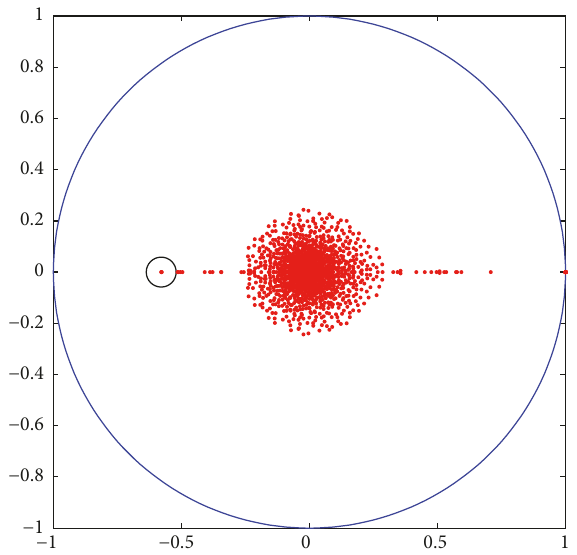
Figure13:NonzeroeigenvaluesforWikipediawho-votes-on-whom network after removing sources.